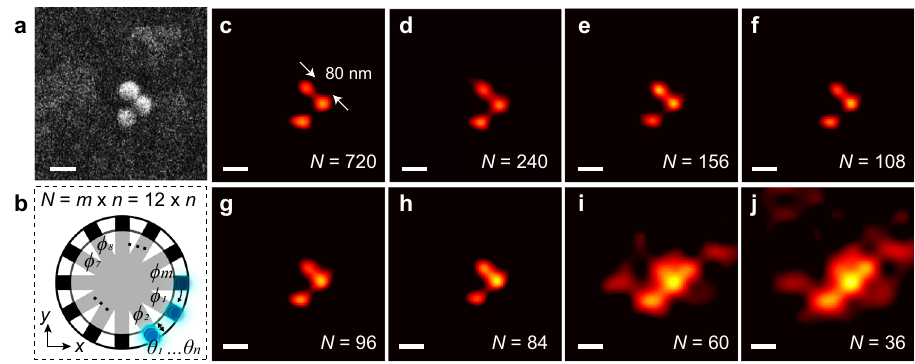
Fig. 5 | Comparison of reconstructed images based on different numbers of framesin anexperimental demonstration ofHMES nanoscopy. a SEM image of three polystyrene beads of 80nm in diameter. Scale bar: 100nm. b The BFP con- fi guration of the HMES nanoscopy. Total N partial scattering images were gener- ated from m =12 different azimuthal angular illuminations ( ϕ ranging from 0° to